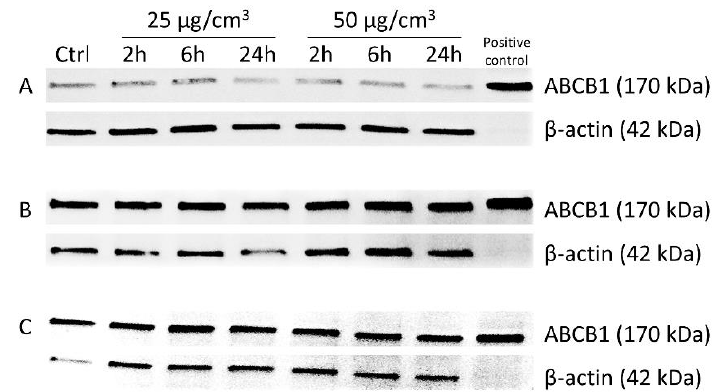
Figure 5. Immunodetection of ABCB1 in A549 ( A ), HepG2 ( B ) and SW620 ( C ) cells treated with 25 and 50 μg/cm 3 Ag20 for 2, 6 and 24 h. MDR1/ABCB1 Sf9 insect membrane was used as a positive control for the presence of ABC protein, and β -actin serves as an internal control.